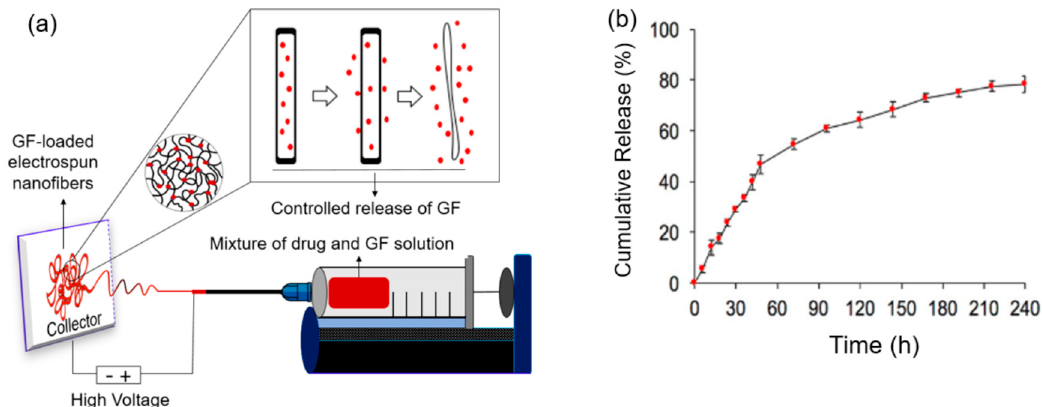
Figure 6. Schematic of the synthesis of growth factor loaded electrospun nanofiber with the controlled release properties ( a ), and VEGF (vascular endothelial growth factor) release profile with respect to time from PCL nanofibers (Reproduced from ref no [123] with permission from ACS Publications, 2018) ( b ).